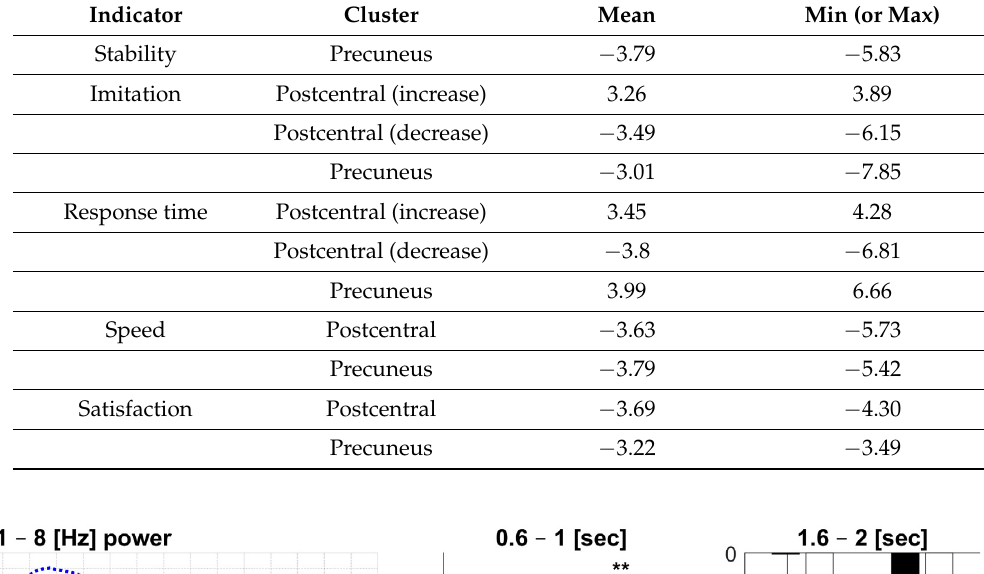
Table 2. T-statistics of significant areas.